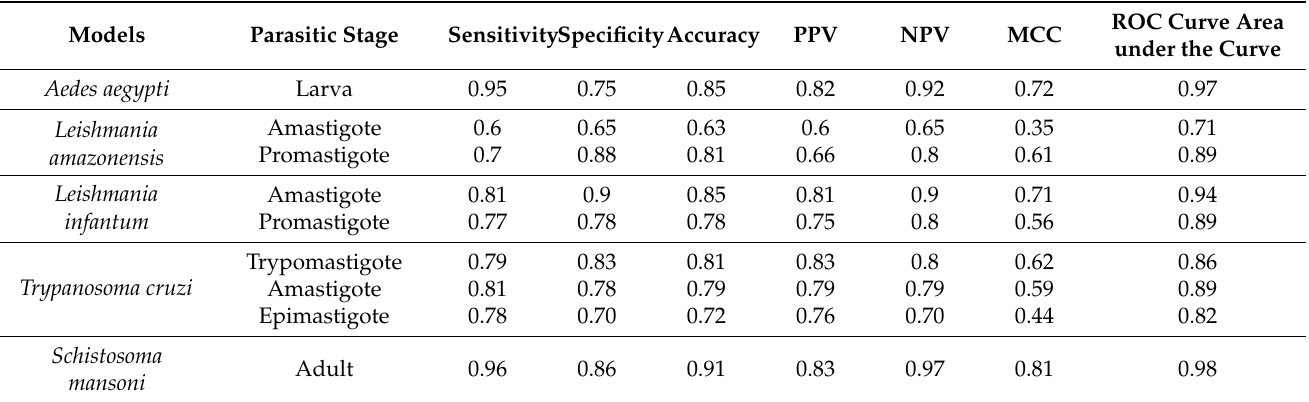
ROC Curve Area under the Curve